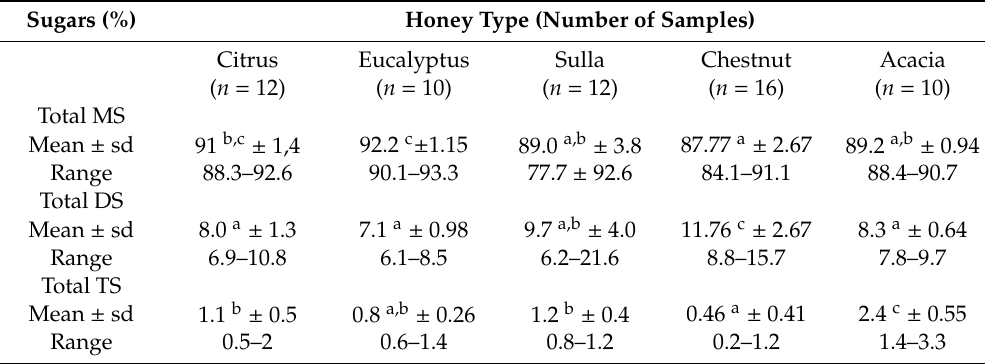
Table 1. Relative abundance (%) of monosaccharides (MS), disaccharides (DS), and trisaccharides (TS) in honey samples from Calabria.